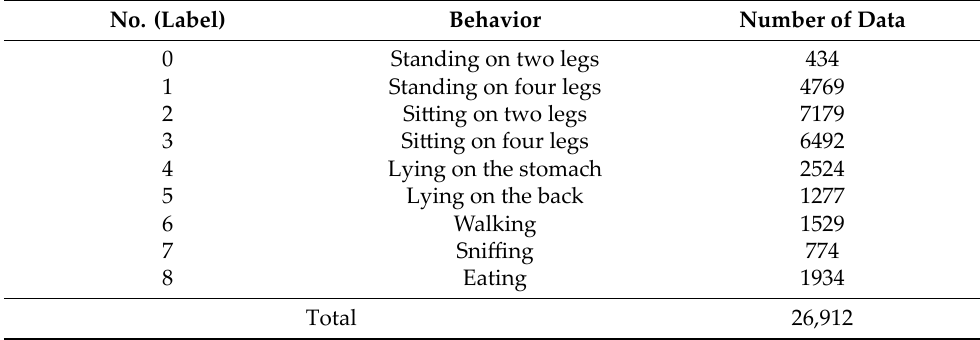
Table 4. Experimental dataset configuration.